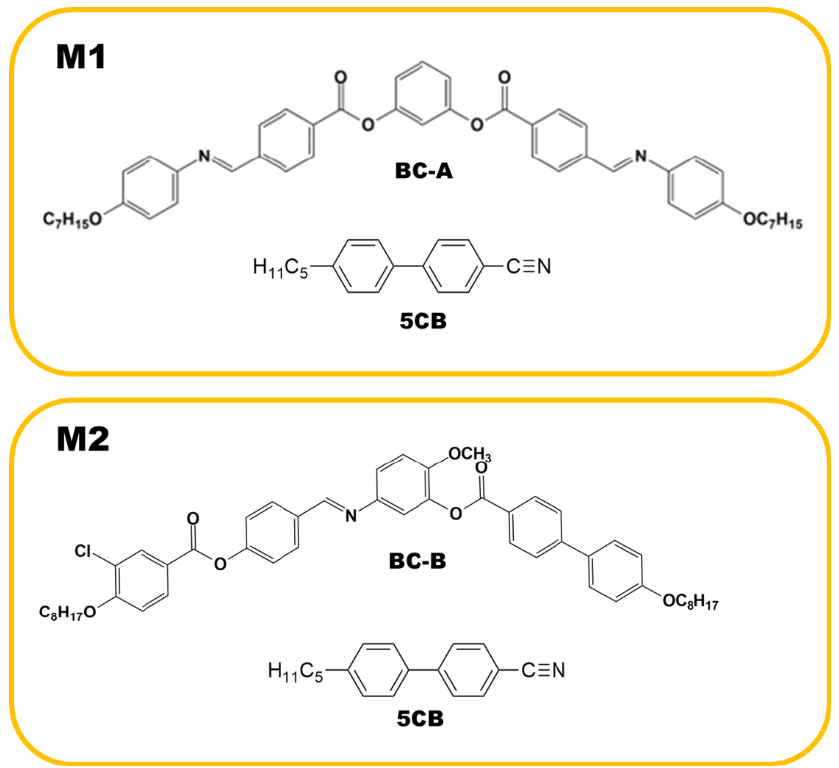
Figure 2. Compositions of M1 and M2 and the chemical structures of BC-A, BC-B, and 5CB.